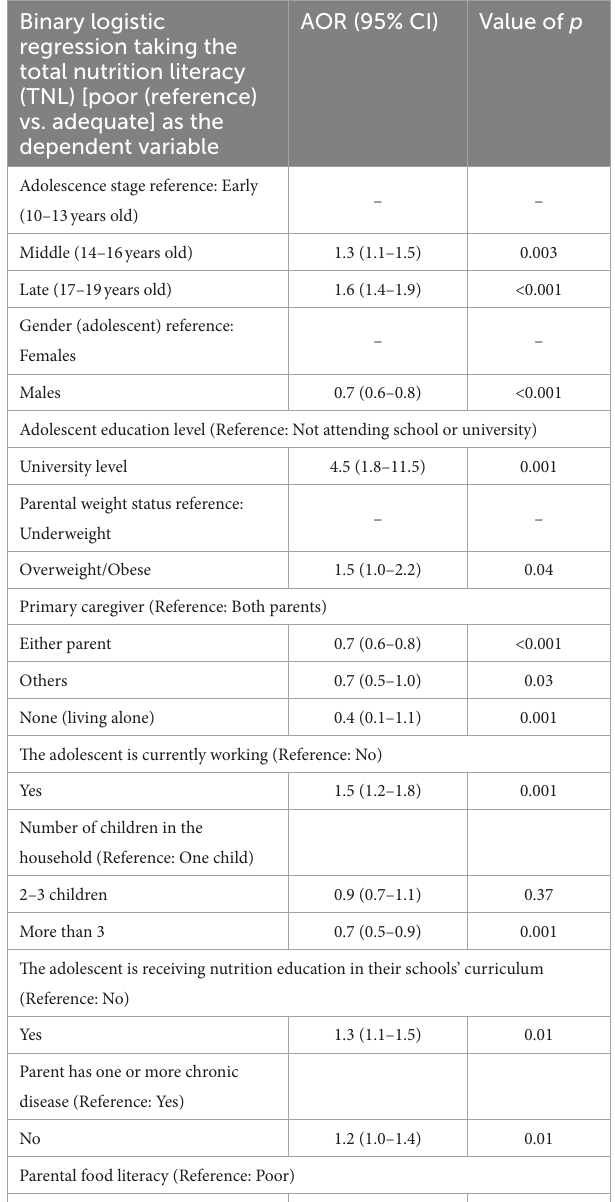
TABLE 4 Predictors factors of adolescents’ nutrition literacy. Binary logistic regression taking the total nutrition literacy (TNL) [poor